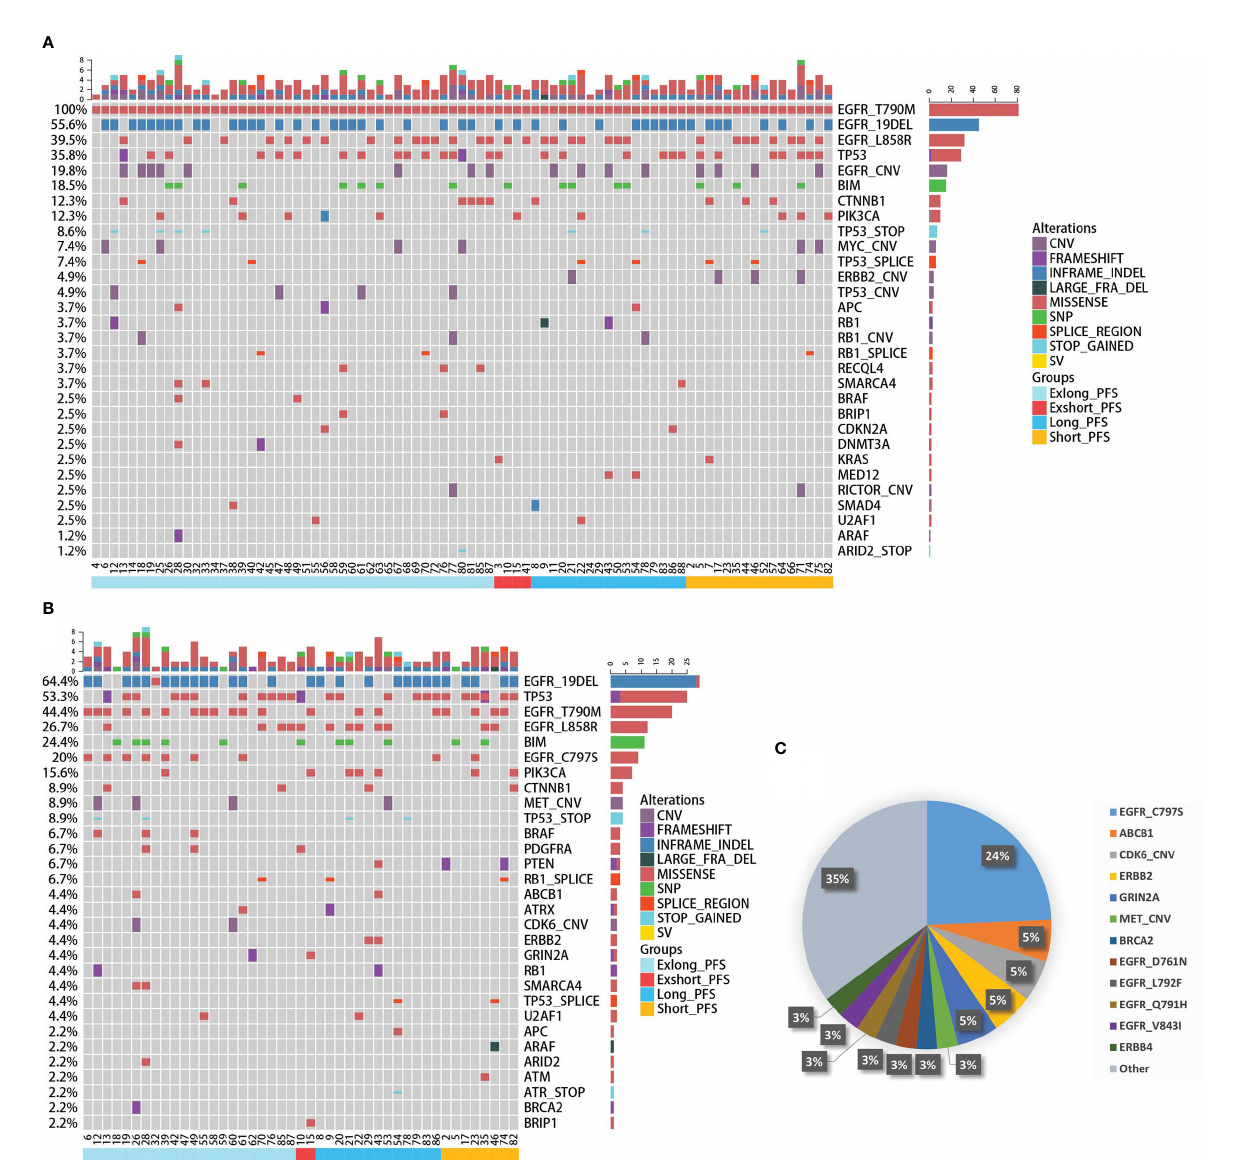
FIGURE 6 | Gene mutation pro fi le based on next-generation sequencing. (A) Somatic gene mutations pro fi le containing the top 30 genes at pretreatment of the third-generation EGFR TKIs. (B) Somatic gene mutations pro fi le containing the top 30 genes at disease progression point for patients with third-generation EGFR TKIs treatment. (C) Resistant gene mutation pro fi le of third-generation